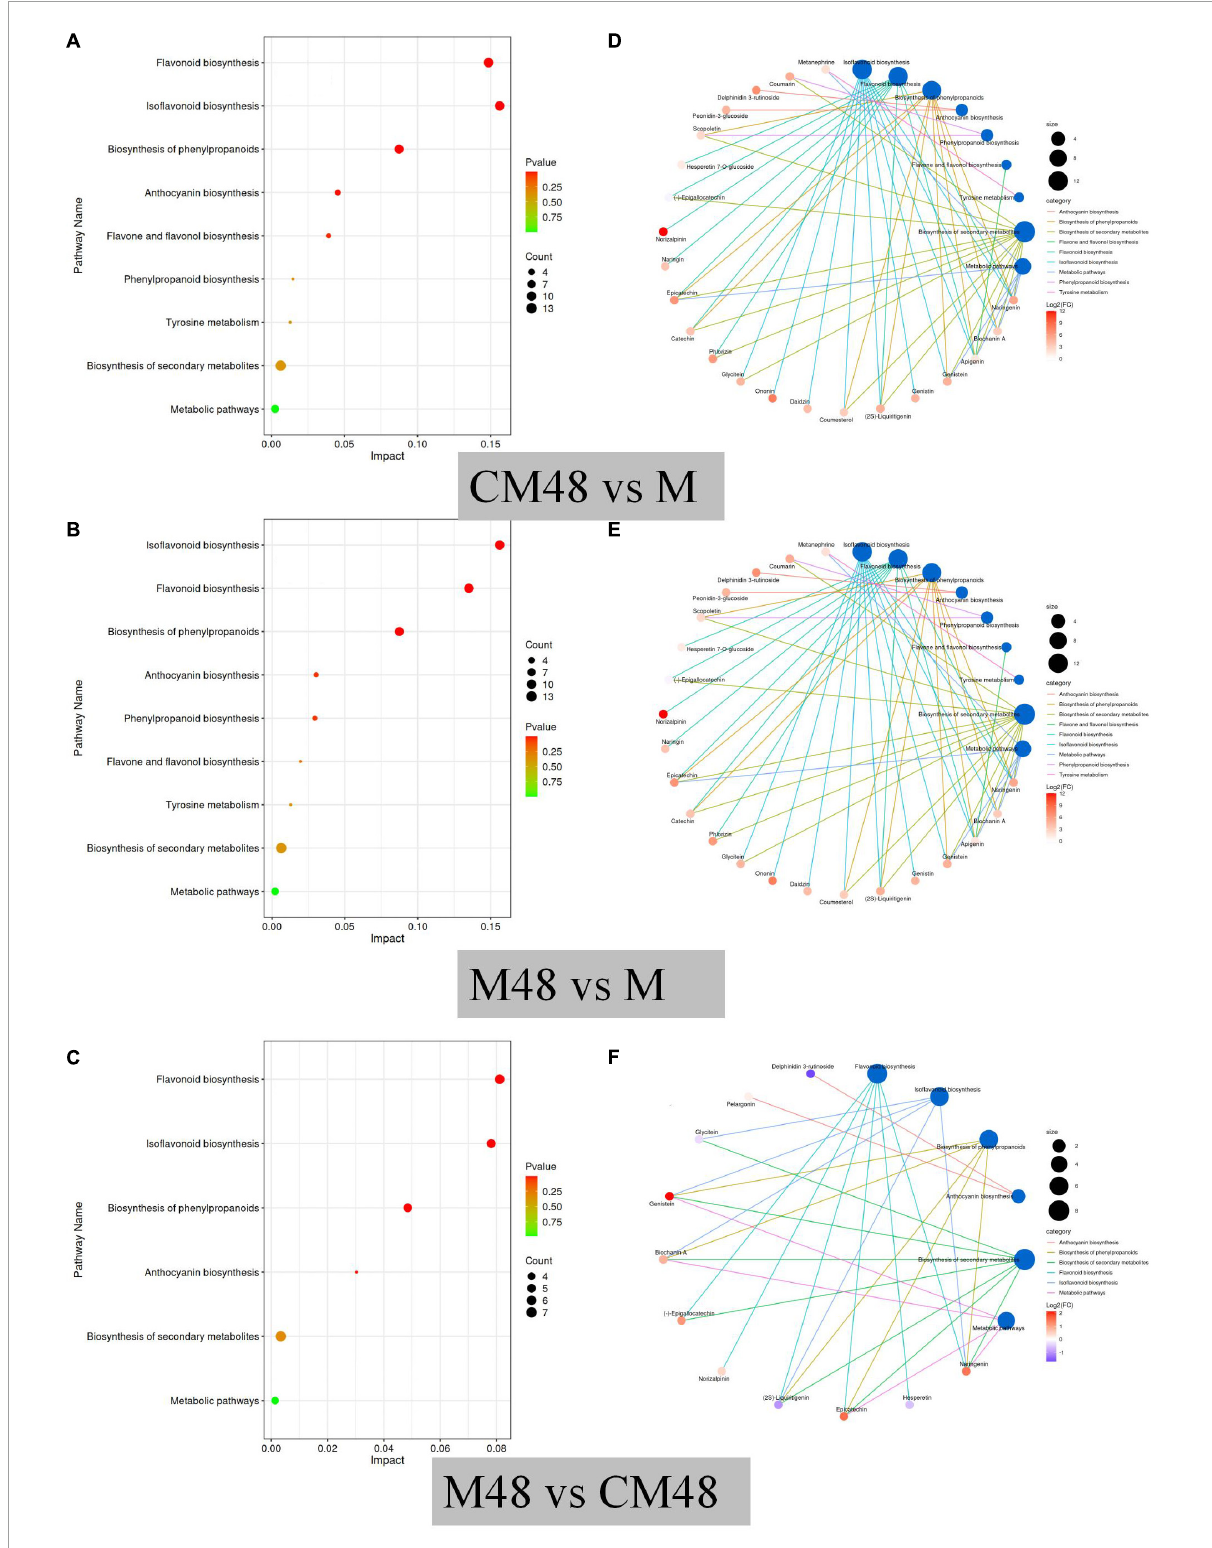
FIGURE9 KEGG pathway enrichment of differential metabolites (A–C) , and network diagram of the distribution of differential metabolites in metabolic pathways (D–F) . M, ungerminated mung bean; CM48, mung bean germinated for 48 h; M48, mung bean pretreated with a combination of ultrasonic and γ -aminobutyric acid (GABA) and germinated for 48